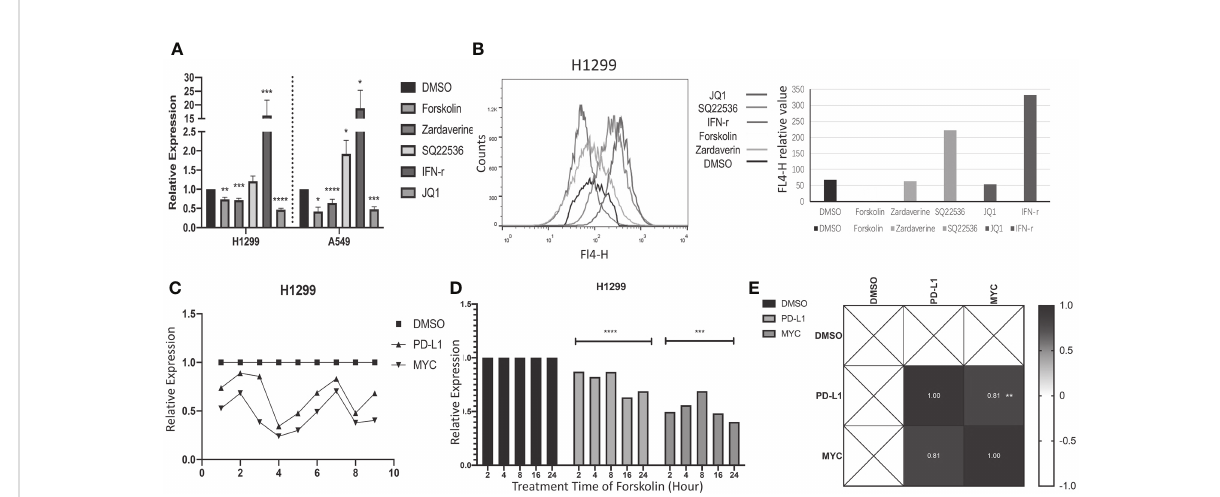
FIGURE 4 The cAMP pathway regulates the expression of PD-L1 and MYC in a cell experiment. (A) : qRT-PCR was used to detect the expression of the PD- L1 gene in the H1299 and A549 lung adenocarcinoma cell lines after treatment with forskolin, zardaverine, JQ1, SQ2253, and IFN-gamma. The drug treatment groups showed signi fi cant differences when compared to the control group. (B) : PD-L1 protein expression in H1299 cells treated with forskolin, zardaverine, JQ1, SQ2253, and IFN- g was detected using fl ow cytometry. There was a signi fi cant difference between the groups (P < 0.001). (C) : The mRNA expression of PD-L1 and MYC in multiple H1299 cell samples treated with forskolin was detected by qRT- PCR. (D) : The gene expression of PD-L1 and MYC in the H1299 cell line treated with forskolin for 2, 4, 8, 16, and 24 hours was detected by qRT- PCR. The comparison between different time points revealed signi fi cant differences (p<0.001). (E) : Correlation analysis of PD-L1 and MYC mRNA expression in H1299 cells treated with forskolin. In (A, D) : data shown are mean ± SD of the triplicate experiments. *p<0.03, ** p<0.002, *** p<0.0002, ****